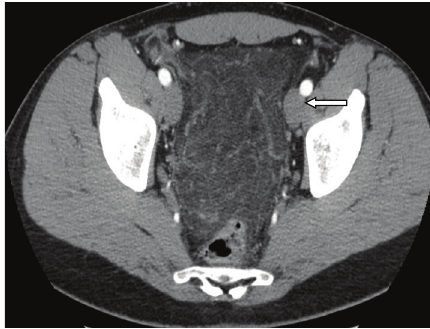
Figure 2: Axial contrast-enhanced CT scans obtained at the pelvis.